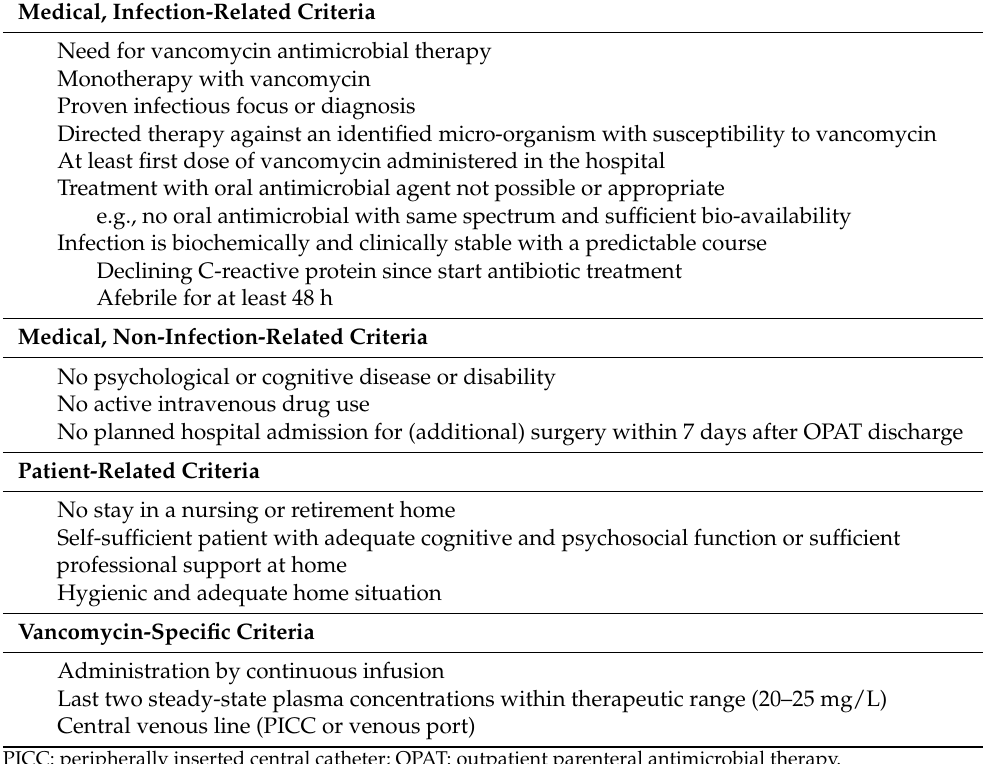
Table 1. Inclusion and exclusion criteria for the vOPAT program of the University Hospitals